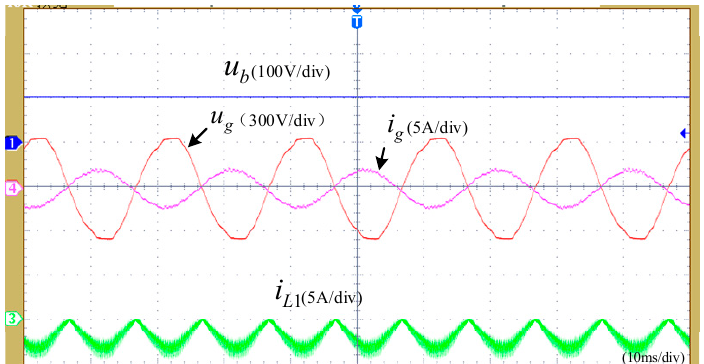
Figure 11. The experimental waveform of the presented converter operating as reactive power compensation equipment ( P = 0, Q = − 400 var, cos ϕ = 0. Energies 2017 , 10 , 881